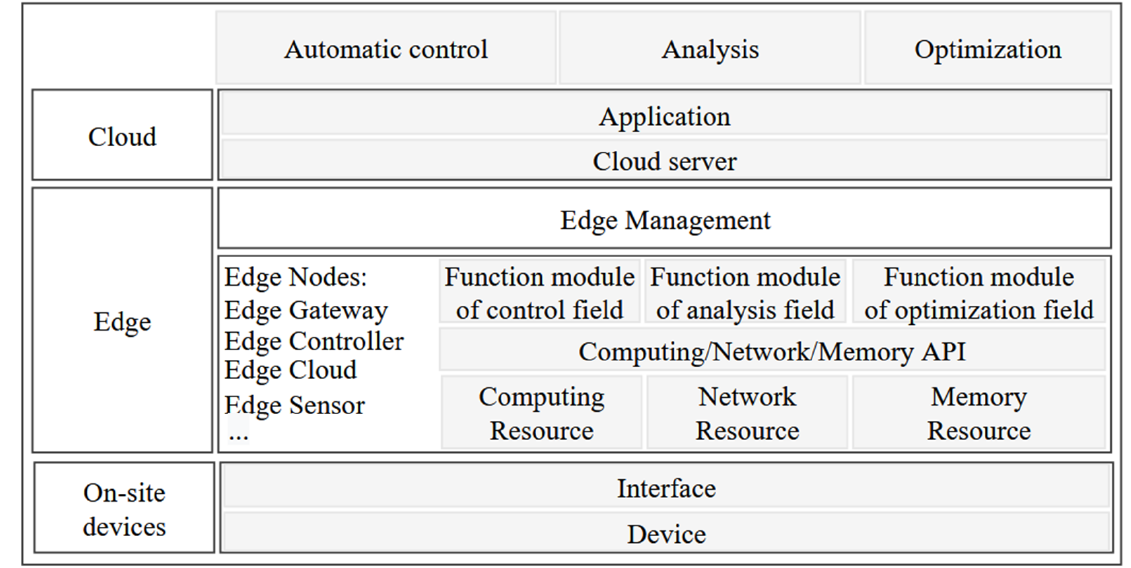
Figure 4. The basic network architecture of edge ‐ computing.